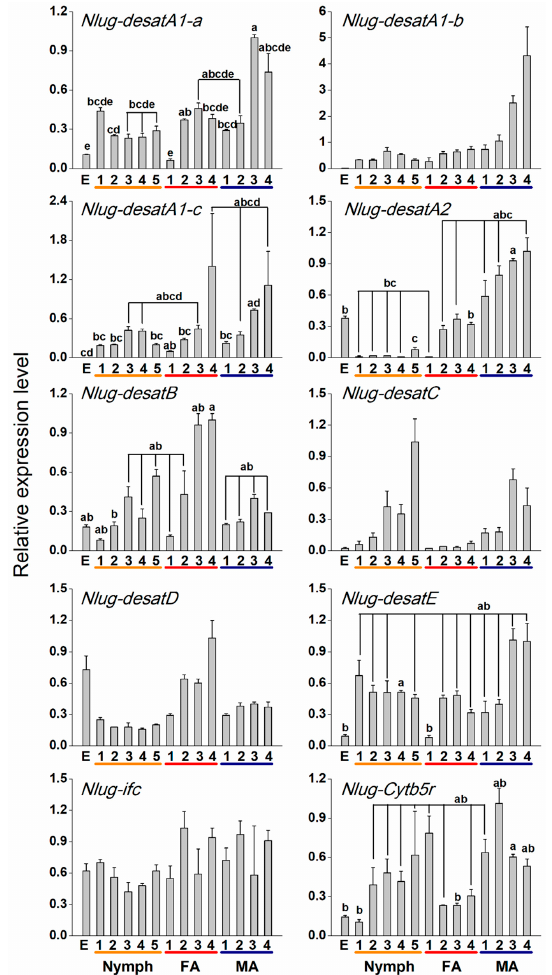
Figure 4. Mean transcript levels (+SE, n = 3) of 10 desaturase genes in different developmental stages of BPH. E, egg; Nymph 1–5, first- to fifth-instar larvae; FA 1–4, 1- to 4-d-old-female adult; MA 1–4, 1- to 4-d-old-male adult. The results (threshold cycle values) of the qRT-PCR assays were normalized to the expression level of RPS15 (ribosomal protein S15e, GenBank accession number: ACN79501.1). Letters indicate significant differences among different treatments (P < 0.05). Statistical information is provided in Table S2 and Table S3.